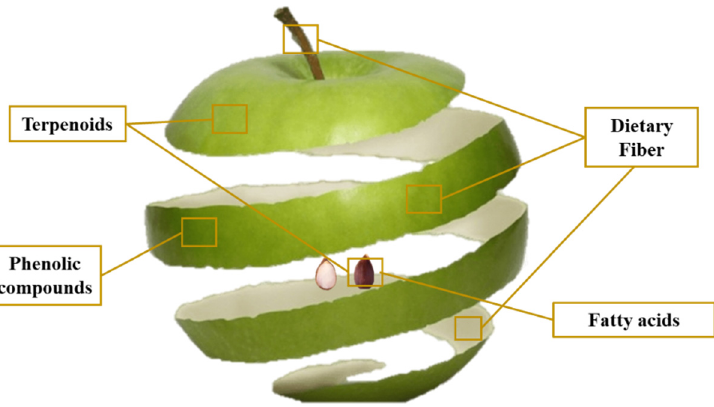
Figure 3. Apple by-product as a source of terpenoids, phenolic compounds, fatty acids, and dietary